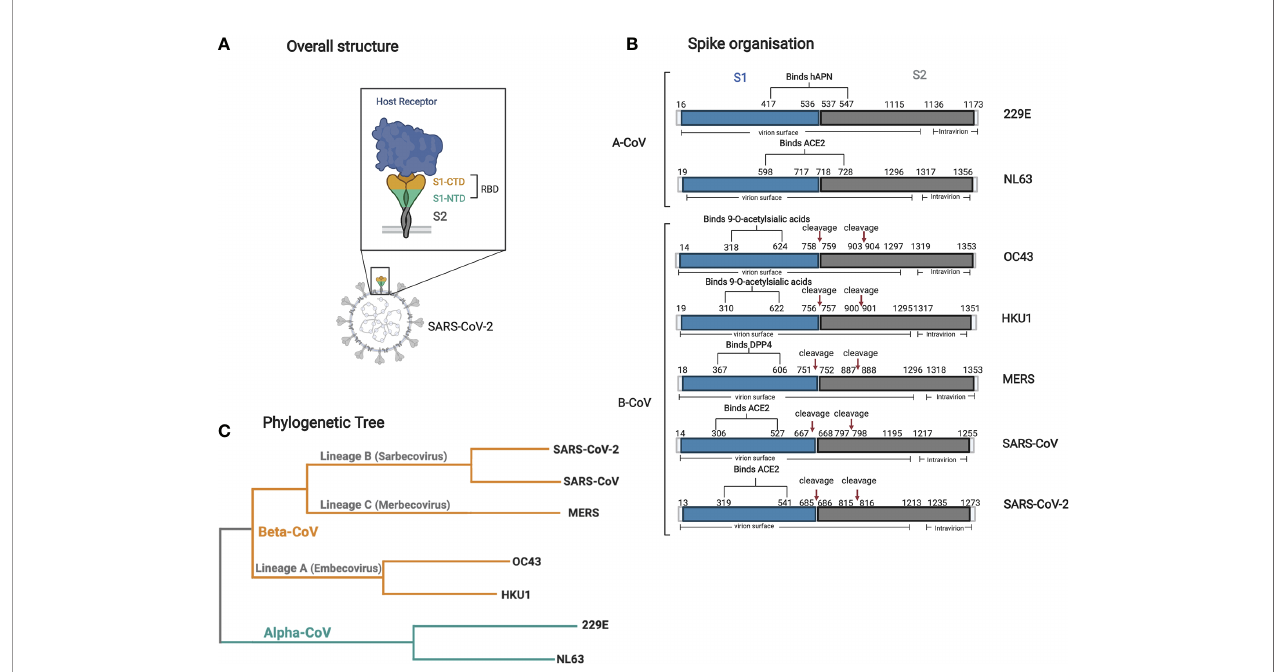
FIGURE 2 | Structure and organization of the spike glycoprotein and phylogenetic tree of all seven human CoVs. (A) A cartoon structure of the Spike protein and its receptor (i.e., ACE2) is shown in relation to its localization on the virion surface. The S1 domain interacts directly with the receptor through its RBD via it ’ s C-terminal domain (CTD). (B) Graphical representation of the various spike human CoV proteins. The RBD, S1 (blue), and S2 (gray) domain locations and all other relevant sites (cleavage sites), and other topological features are shown with their respective amino acid sequence number. The information for each spike was obtained